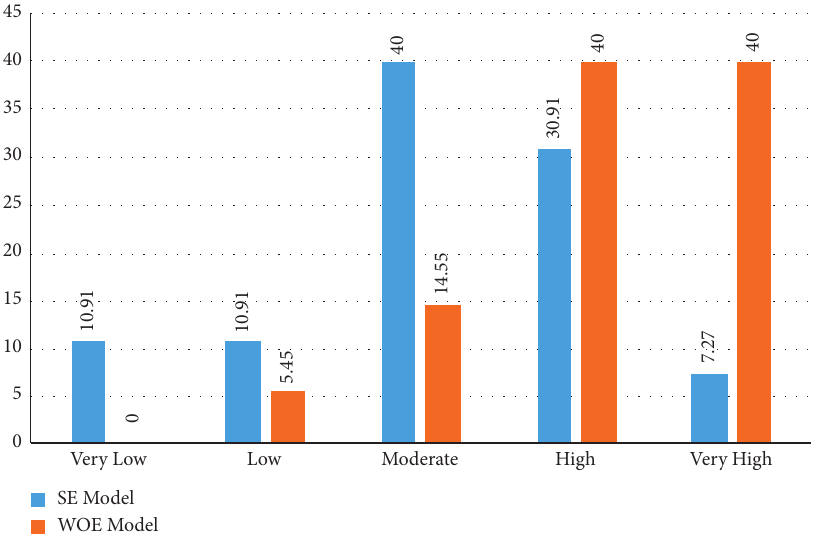
Figure 6: Distribution of classes on landslide susceptibility maps.